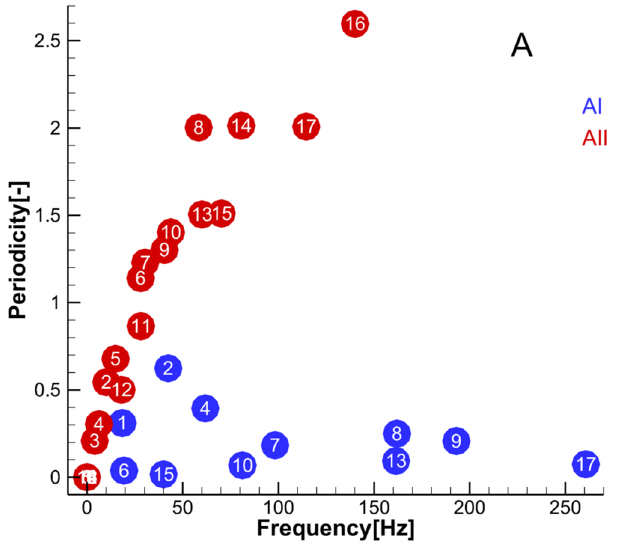
Fig. 10. OPD modes, frequency and periodicity for the branch A. Zone I in blue, zone II in red.